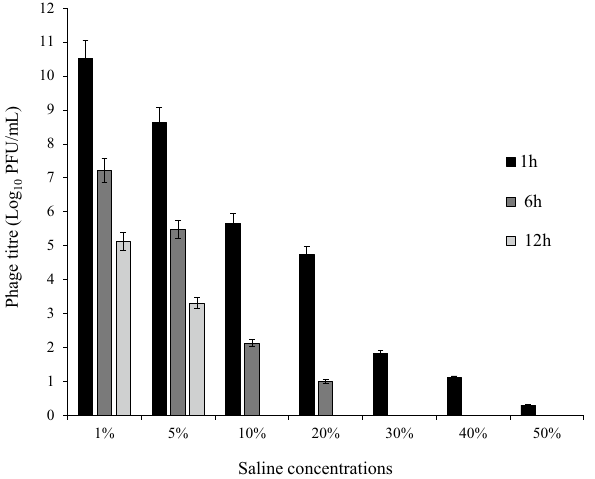
Figure 6. Stability of vB_EfaS-SRH2 phage at different saline concentrations (1–50%). The results are presented as the mean ± SD. Error bars indicate the standard deviation.